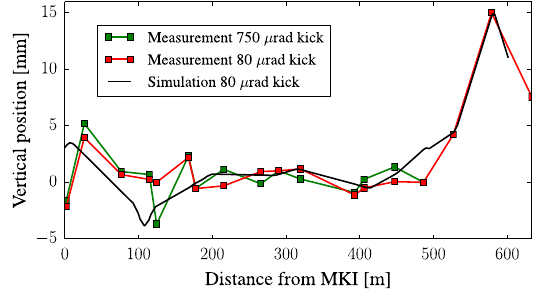
FIG. 4. Vertical trajectory of the injected beam. Black line: MAD-X simulation of injection with 80 μ rad kick by MCBCV.9R2 vertical orbit corrector. Red line: BPM readings for of 80 μ rad kick. Green line: BPM readings for 750 μ rad kick.